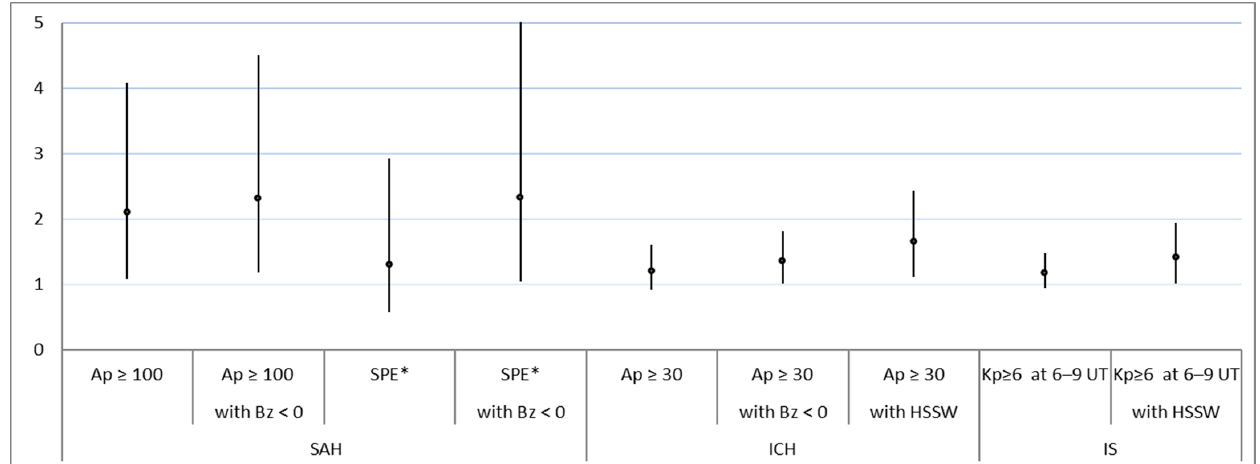
Figure 2. Associations between stroke occurrence and space weather variables in a time-stratified multivariate model since 1995 (RR adjusted for month, the day of the week, air temperature, change in atmospheric pressure, relative humidity, and low GMA). * days of the maximum of strong/severe SPE.